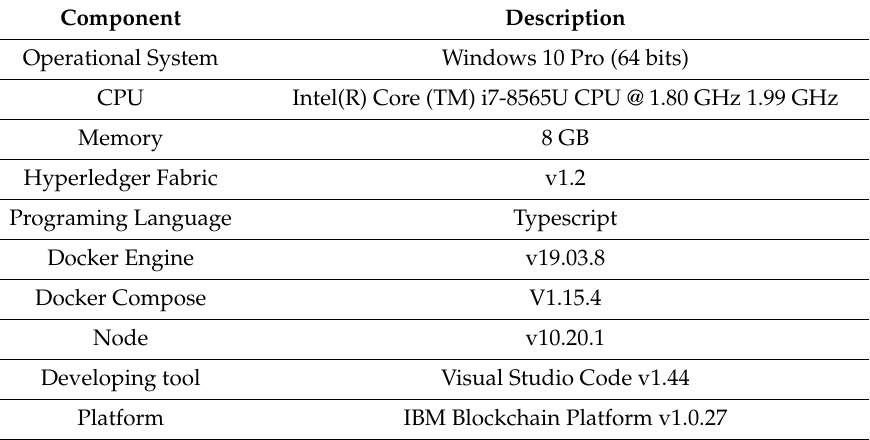
Table 9. Implementation and execution